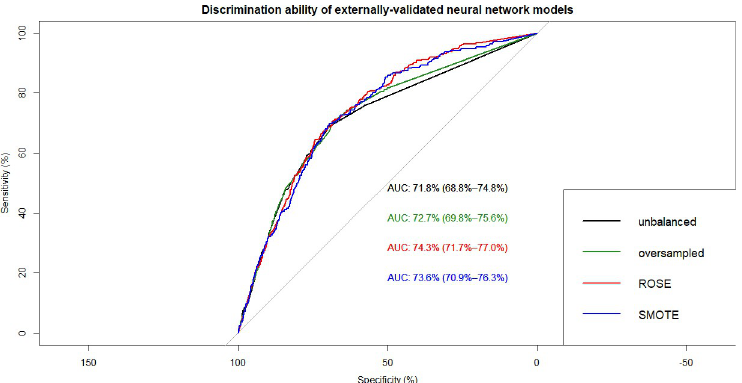
Fig 7. Overlapped ROC curves demonstrating predictive performance of artificial neural network models on external validation data. Using unbalanced, original training data and re-structured with oversampling, ROSE and SMOTE resampling.